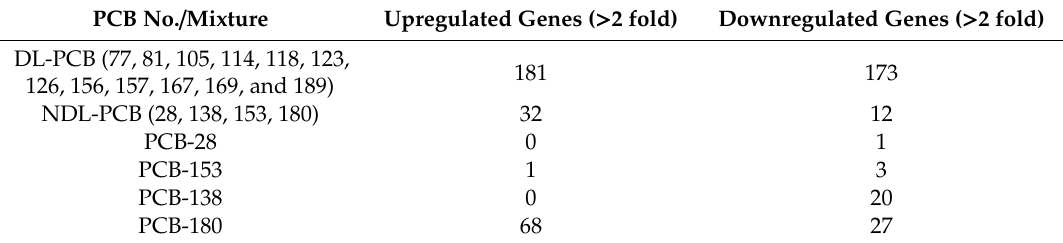
Table 1. Dysregulated genes in PBMCs after treatment to NDL- or DL-PCB mixtures or single congener (28, 138, 153, 180). PCB No. /